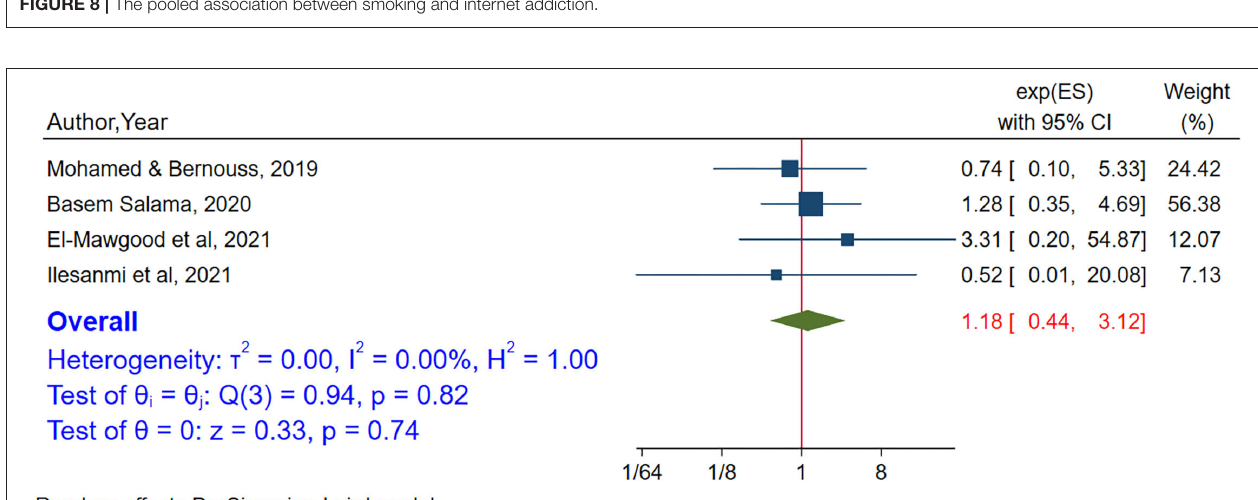
FIGURE 8 | The pooled association between smoking and internet addiction.